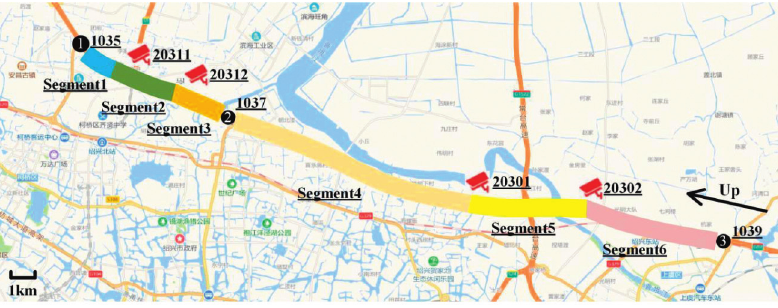
Figure 4: Target highway. Table 1: Basic information of each segment.